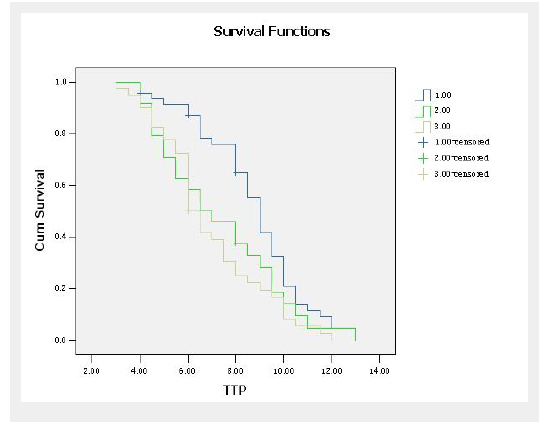
Association between the combination of GSTP1A313G and XRCC1G28152A polymorphisms (group 1: GSTP1 A/G+G/G and XRCC1 G/G genotype, group 2: GSTP1 A/G+G/G and XRCC1 G/A+A/A genotype, group 3: GSTP1 A/A and XRCC1 G/A+A/A genotype) and time to progression (TTP) in patients with advanced NSCLC receiving platinum- based chemotherapy. The vertical hash marks denote the time of last follow up for those patients lost to follow